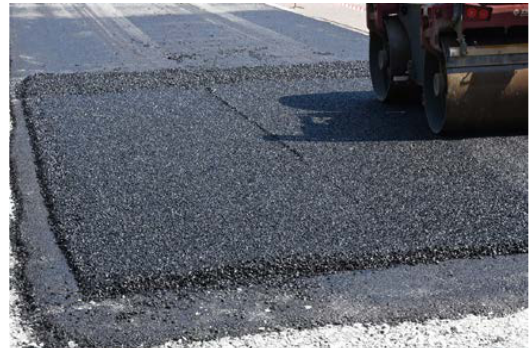
Figure 15. Compacting of PA 11 mixture.